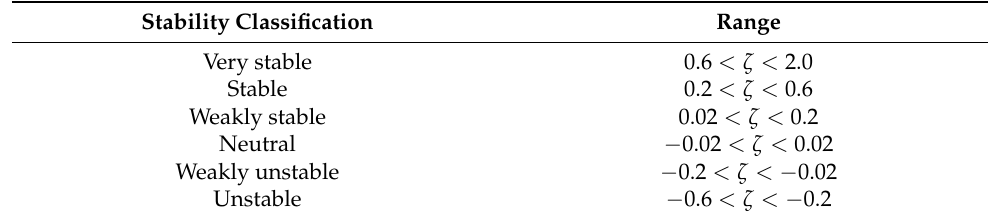
Table 1. Atmospheric stability classification scheme as suggested in [42].